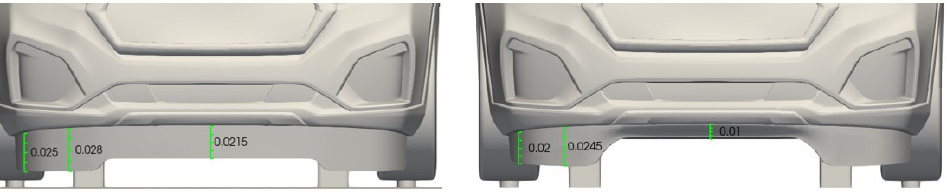
Figure 16. Air dam geometry for the reference case ( left view ) measured in the wind tunnel and the local optimized case ( right view ) with a reduced total height.